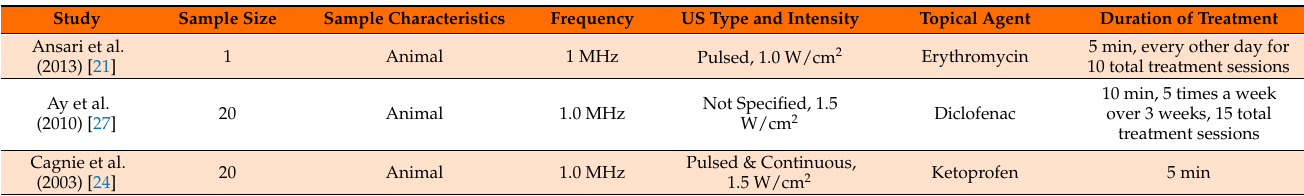
Table 1. Current Literature on